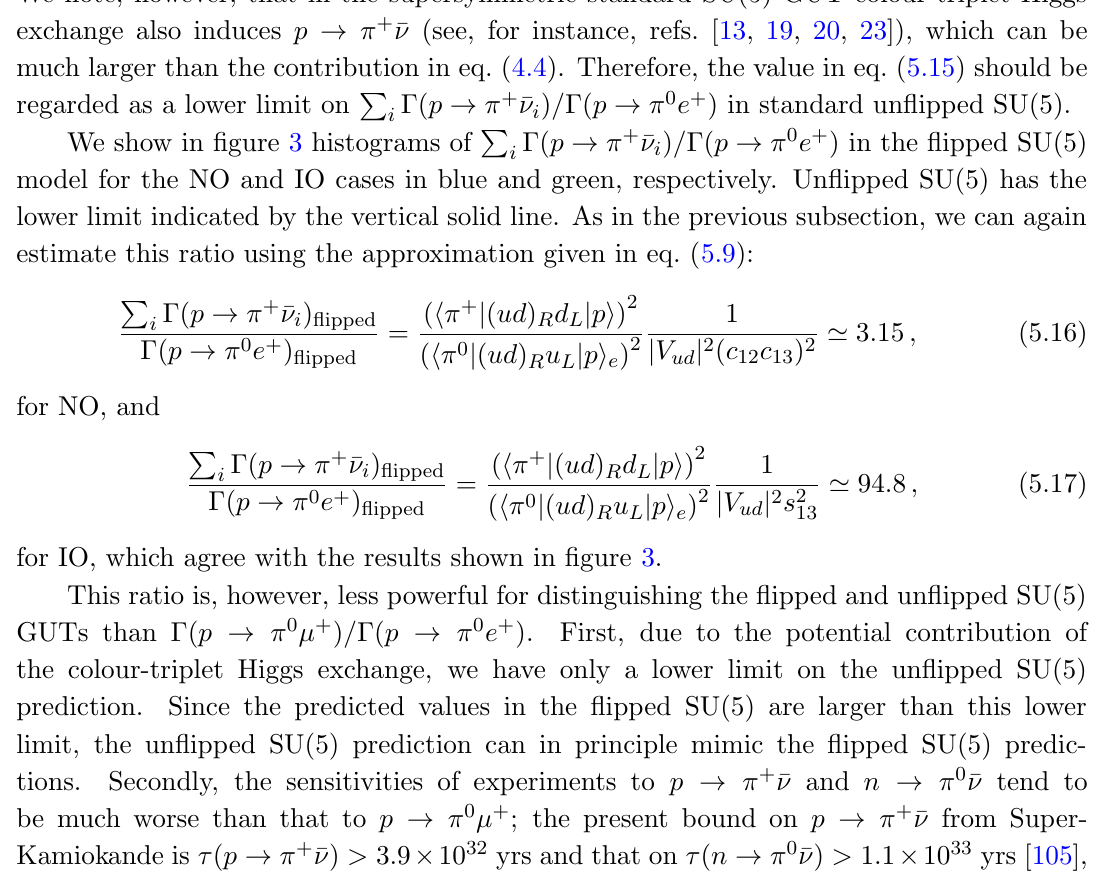
Figure 3 . Histograms of in blue and green, respectively. The un(cid:13)ipped SU(5) prediction has a lower limit shown as the vertical solid